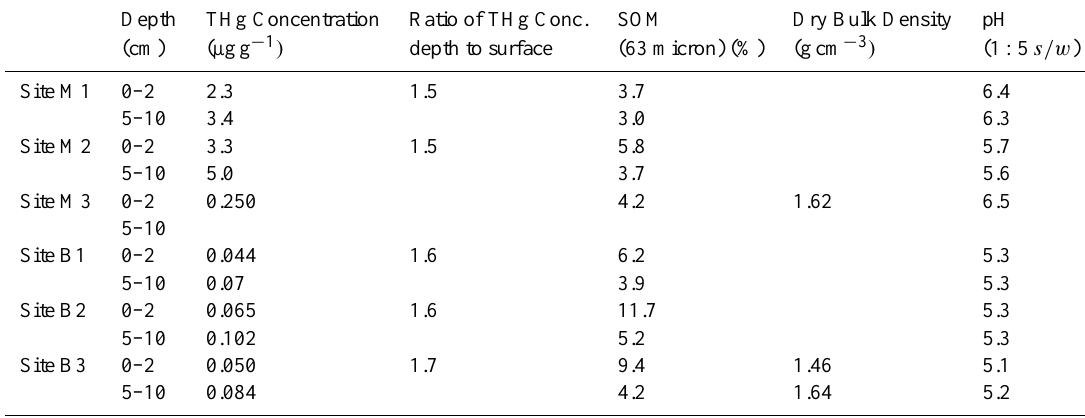
Table 1. Summary of average substrate THg concentration, soil organic matter, bulk density and pH. Depth THg Concentration Ratio of THg Conc. SOM Dry Bulk Density pH (cm) (µgg − 1 ) depth to surface (63 micron) (%) (gcm − 3 ) (1 : 5 s/w ) Site M1